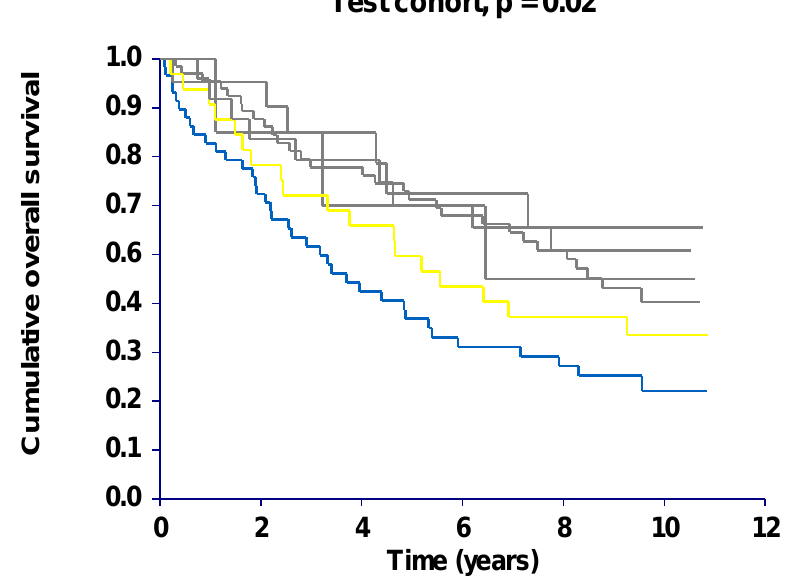
Figure 1. Kaplan-Meier overall survival curves according to haplotype combinations. The blue line represents patients with the (CTC, ACG) haplotype combination and the yellow line patients with the (CTG, ACG) combination. Patients with the remaining four haplotype combinations are represented by the grey lines, test cohort, n =